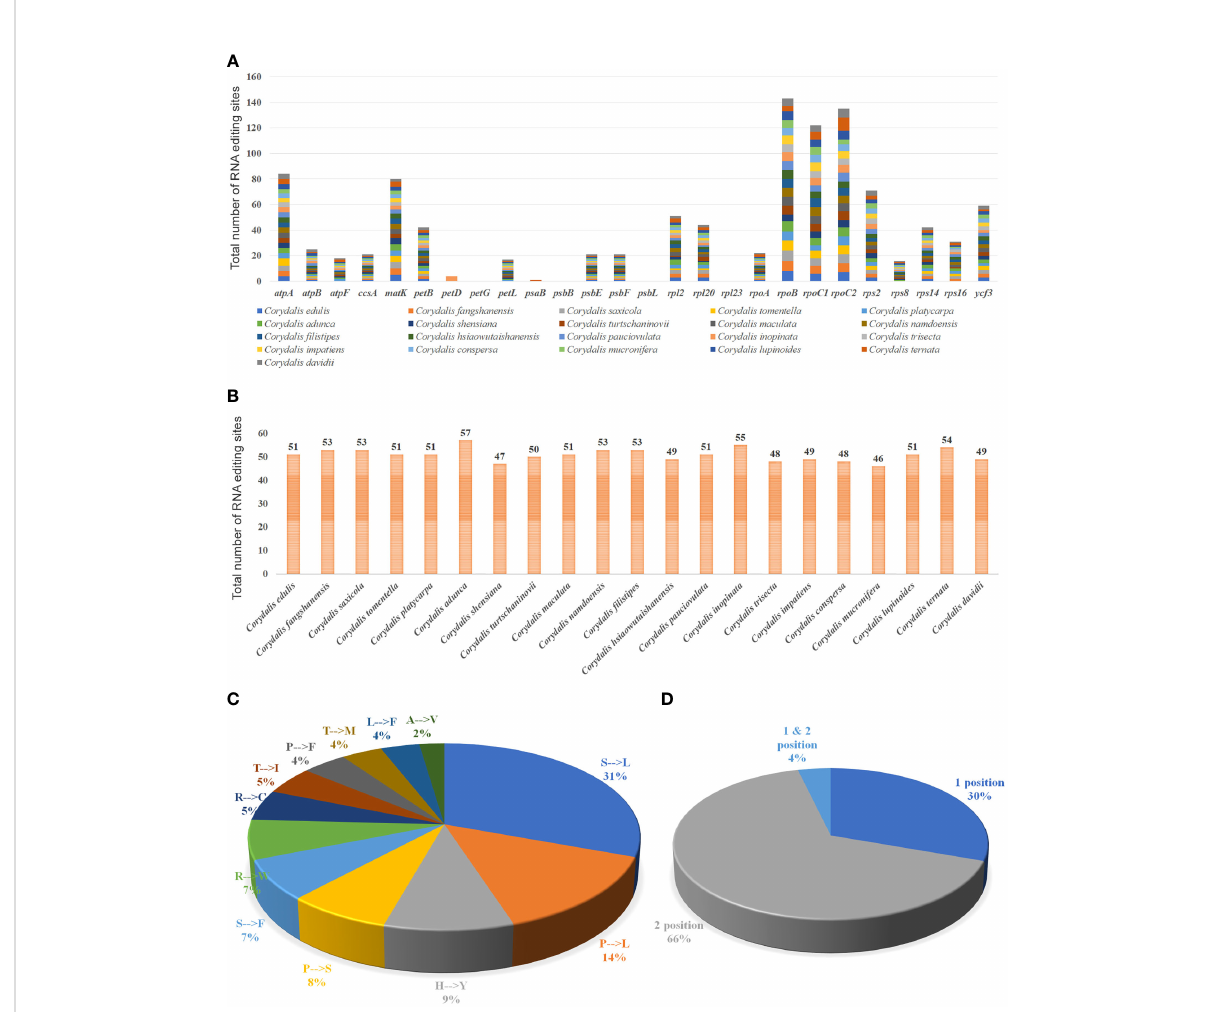
FIGURE 5 Analyses of RNA editing in the 35 protein-coding genes of the 21 Corydalis plastomes. (A) the distribution of RNA editing sites in the protein- coding genes of each Corydalis genome. (B) The number of RNA editing sites in each Corydalis cp genome. (C) Pie diagram represents the conversion percentage of amino acids in the RNA editing sites. (D) Represents the RNA editing site in the triplet codon of the nucleotide. S, serine; L, leucine; P, proline; H, histidine; Y, tyrosine; F, phenylalanine; R, arginine; W, tryptophan; C, cysteine; T, threonine; I, isoleucine; M, methionine; A, alanine; V,